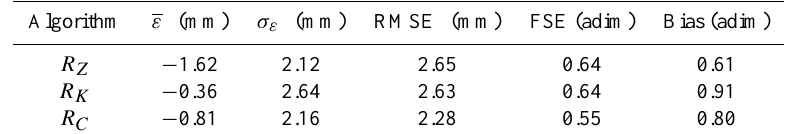
Table 1. Error scores computed on hourly cumulated rainfall for the event observed on 21 February 2013. RMSE refers to the root-mean- square error; FSE refers to the fractional standard error; “adim” represents adimensional ratios.